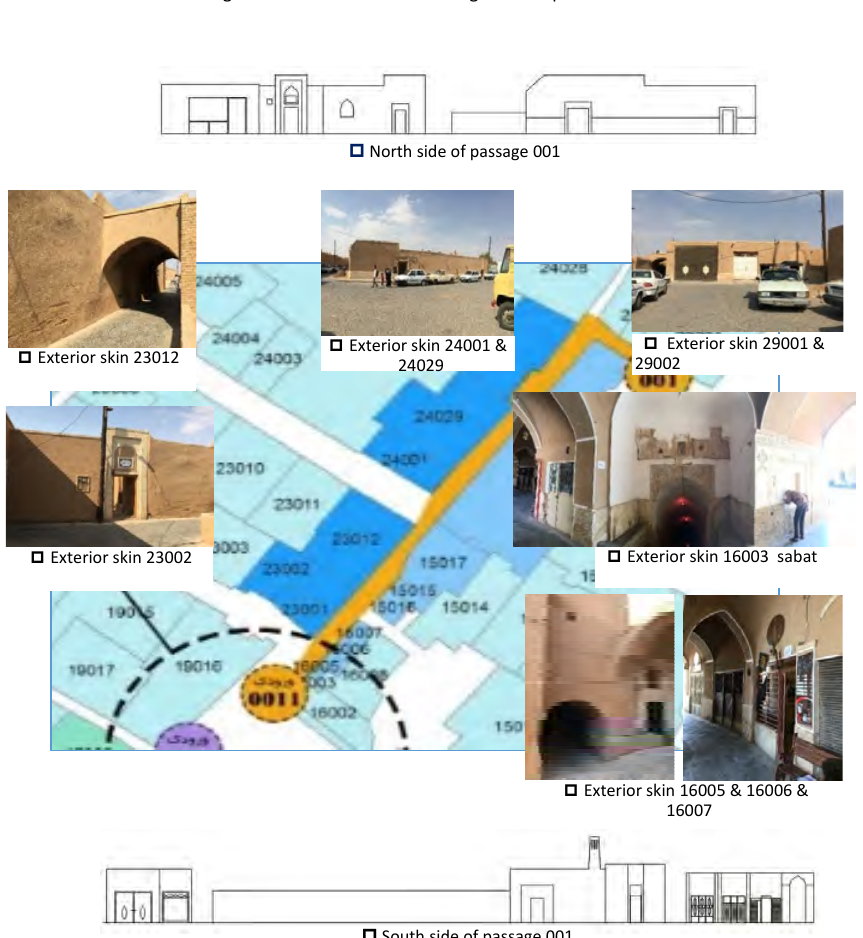
Fig. 5: Passage exterior skin of 001 Shah Abolghasem district of Yazd